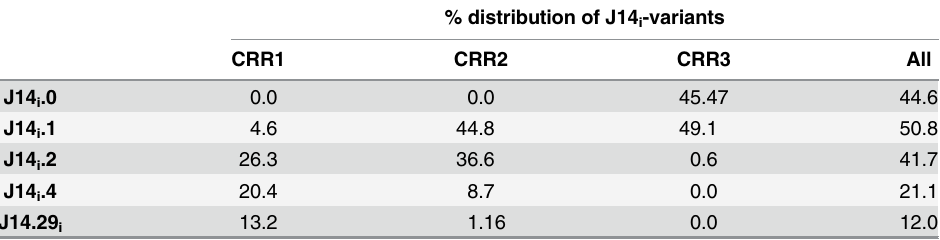
Table 3. Distribution of J14 i variants in CRUs.